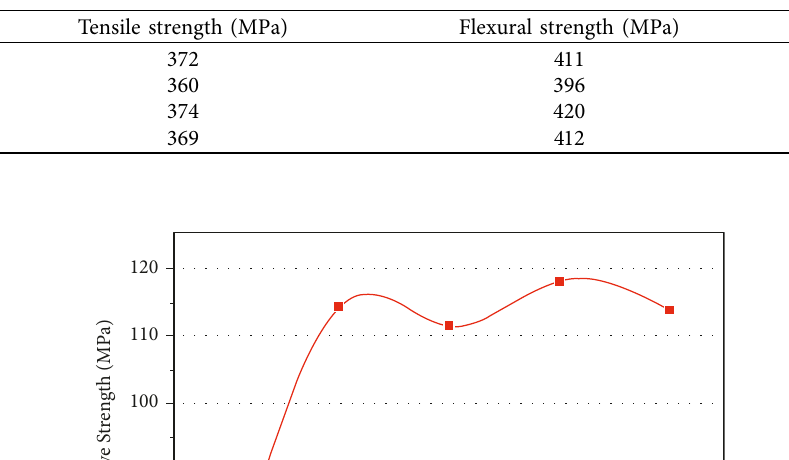
Table 2: Maximum mechanical properties of composites.